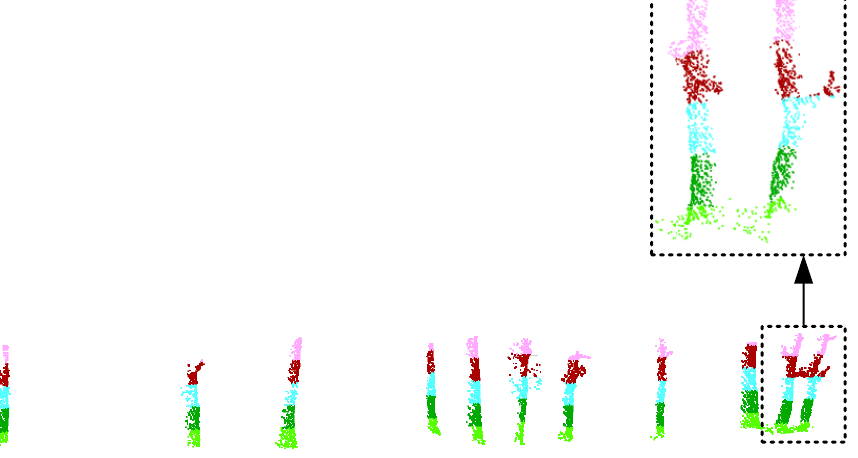
Figure 2. Trunk vertical layering. The different colors represent different vertical layers .